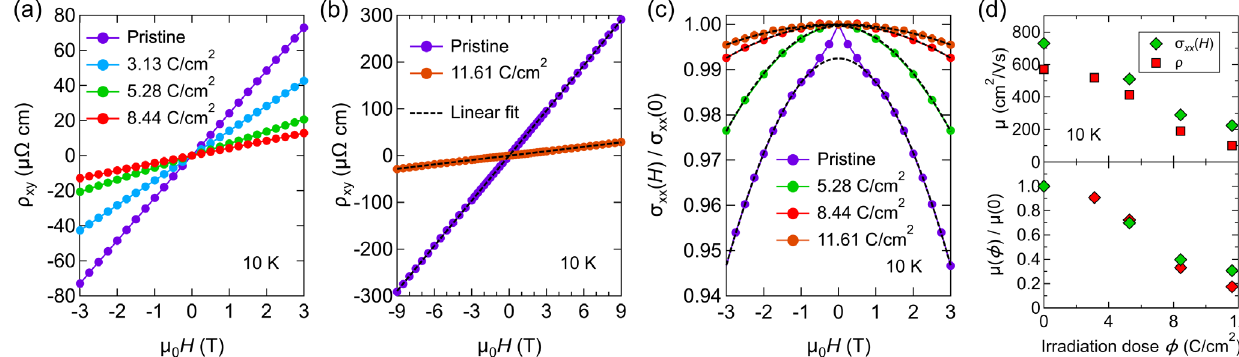
FIG. 8. Magnetotransport in LuPdBi before and after irradiation. (a,b) Hall resistivity as a function of magnetic field measured at 10 K in pristine and electron-irradiated samples up to 3 T (a) and 9 T (b). (c) Field dependence of the longitudinal magnetoconductivity normalized by the value at zero field measured at 10 K. The black dashed lines are fitting curves represented as σ ð H Þ ∝ 1 = ½ 1 þ μ 2 ð μ H Þ 2 (cid:2) . (d) Mobility calculated from the σ ð H Þ (green diamonds) and the resistivity ρ (red diamonds) as a xx 0 xx function of the irradiation dose ϕ (upper panel). Normalized mobility by the value in the pristine sample is also shown (lower